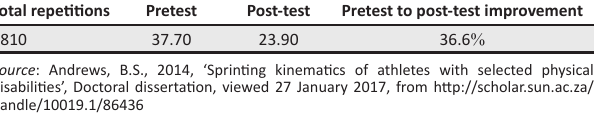
FIGURE 3: Accuracy improvements from the pretest evaluation to the post-test evaluation in the IM™ training. TABLE 1: Pretest and post-test adjustment values and improvement following Interactive Metronome™